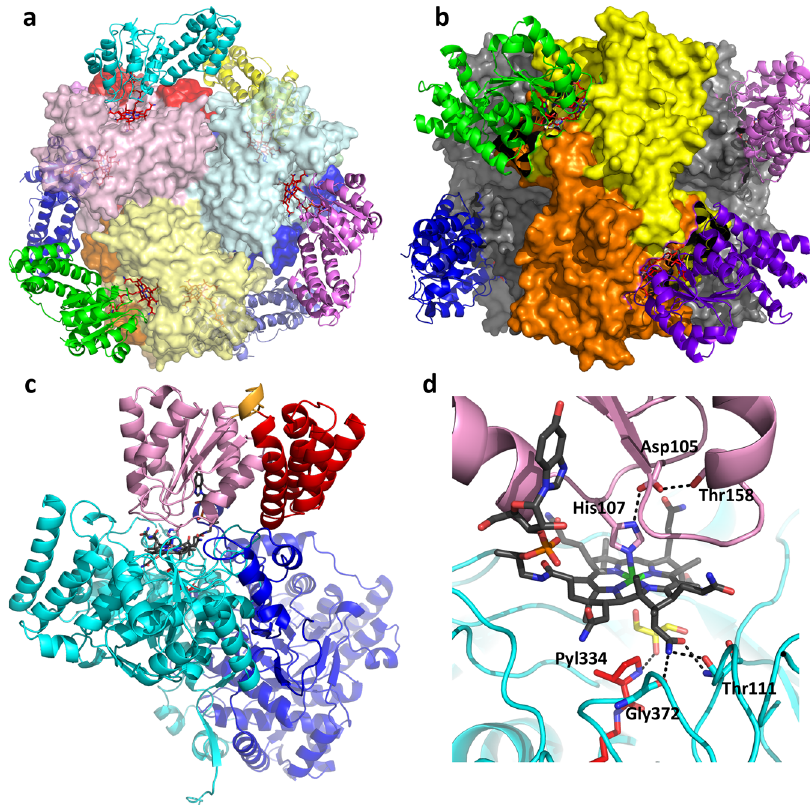
Fig. 3 Structure of MttB-MttC complex. Overall structure of MttB-MttC hetero-dodecamer viewed along ( a ) the threefold axis, and ( b ) the twofold axis. MttB subunits colored as in Fig. 1a and shown as surface, corrinoid cofactors shown as red stick and sit in the active site groove of MttB subunits. MttC subunits are shown in ribbon and colored by subunit. c Each MttC subunit interacts with a MttB dimer pair in the MttB-MttC complex. MttC colored by region: helical cap domain (residues 2 – 84) in red, core domain (residues 96 – 216) in pink, connecting loop (residues 85 – 95) in orange, and corrinoid cofactor shown as gray stick. One MttB subunit (cyan) interacts with the MttC core domain and corrinoid cofactor, while the second MttB subunit (blue) interacts with both the MttC cap and core. d View of active site of MttB-MttC highlighting important residues and their hydrogen-bonding interactions. The nitrogen of His107 is covalently bound to cobalt. The hydrogen-bonded triad (His107, Asp105, and Thr158) in MttC are shown in stick and labeled. The hydrogen bonds between cobamide (gray stick) and MttB (cyan ribbon), as well as between glycerol (yellow stick) and pyrrolysine (red stick) are shown as dashed black